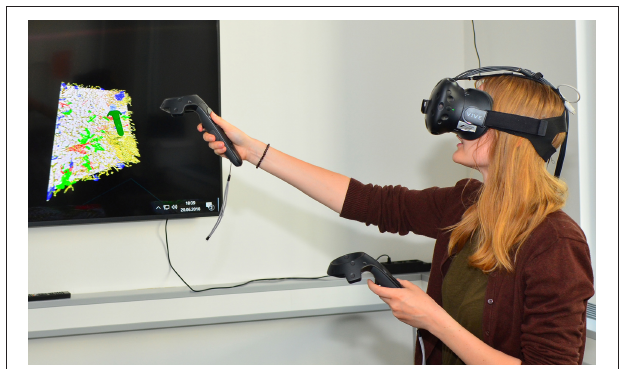
FIGURE 2 | A user in VR. The large display mirrors the headset